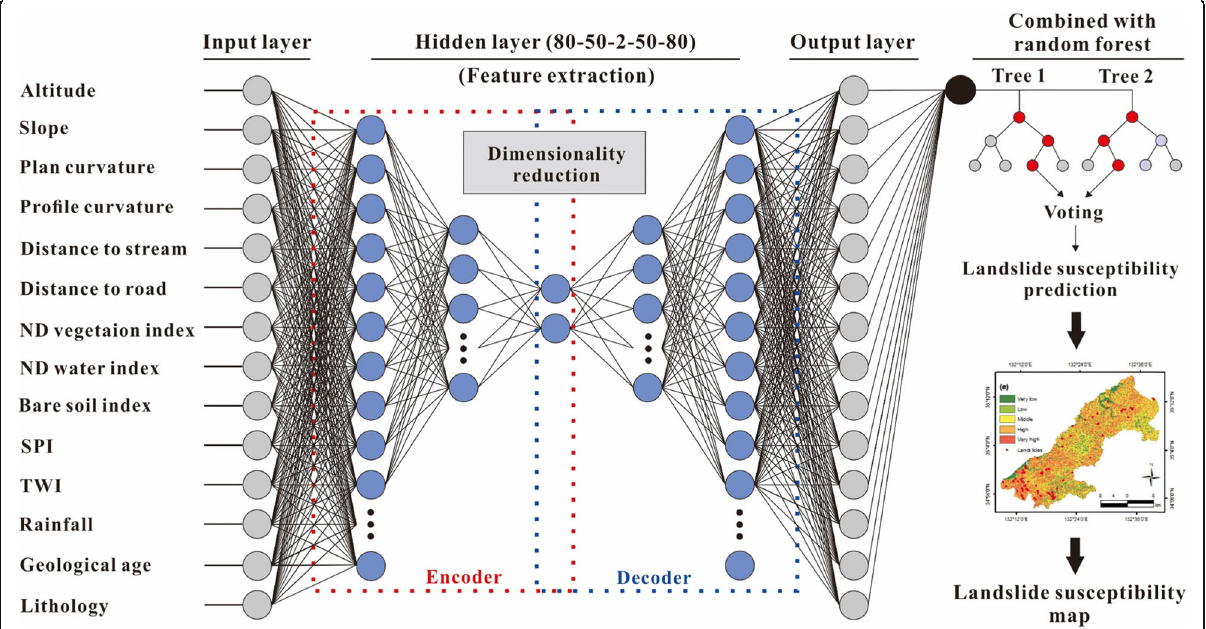
Fig. 7 Architecture of stacked autoencoder combined with random forest employing reconstruction error value by anomaly